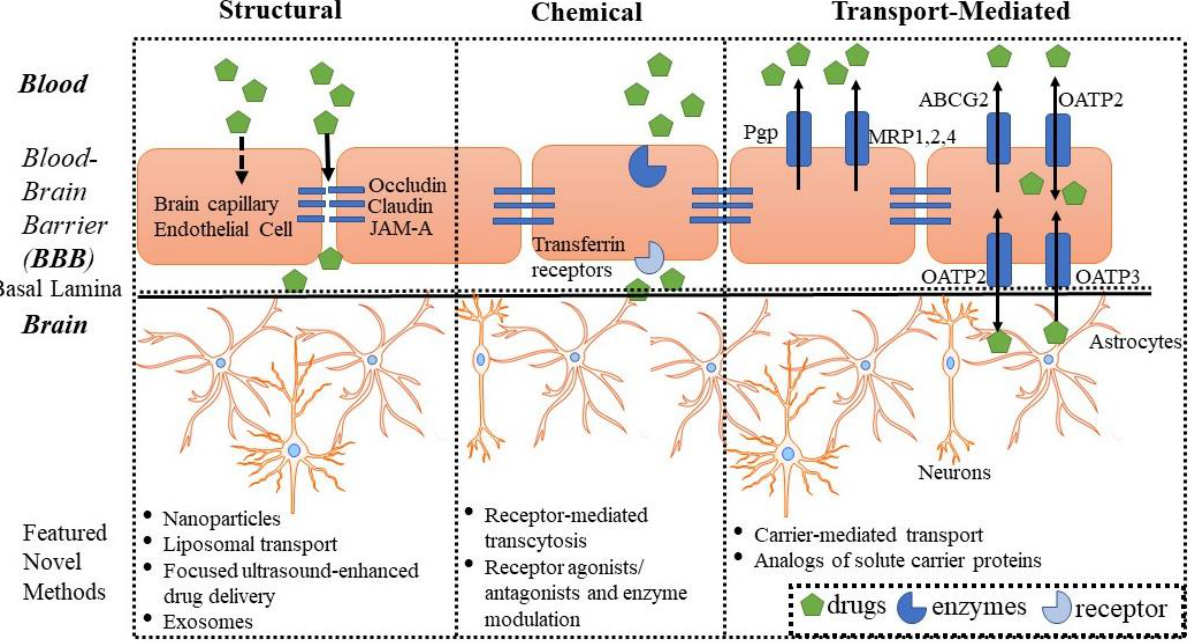
Figure 1. Schematic representation of potential targets and selective novel strategies for drug delivery to the brain across the blood-brain barrier (BBB).